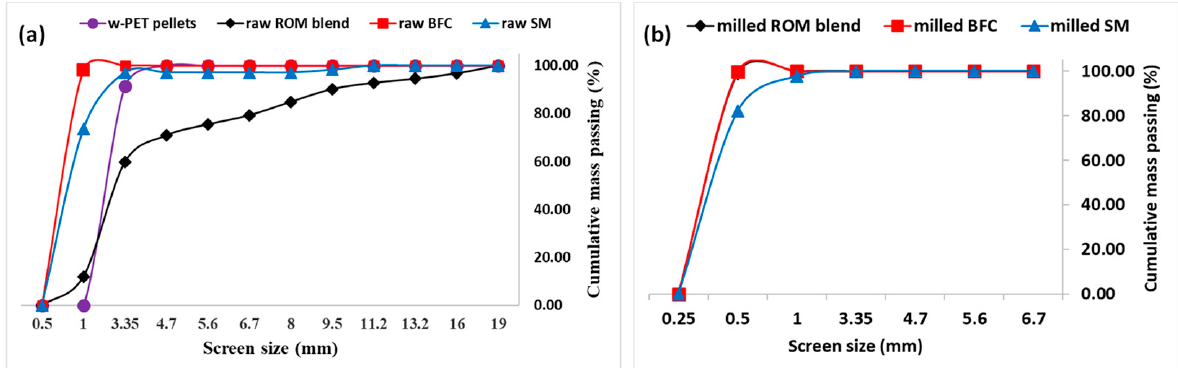
Figure 2. Particle size distribution (PSD) curves obtained from screened w-PET pellets and d-coal samples: ( a ) raw w-PET and raw d-coal samples and ( b ) milled d-coal samples. All the results are based on a dry basis